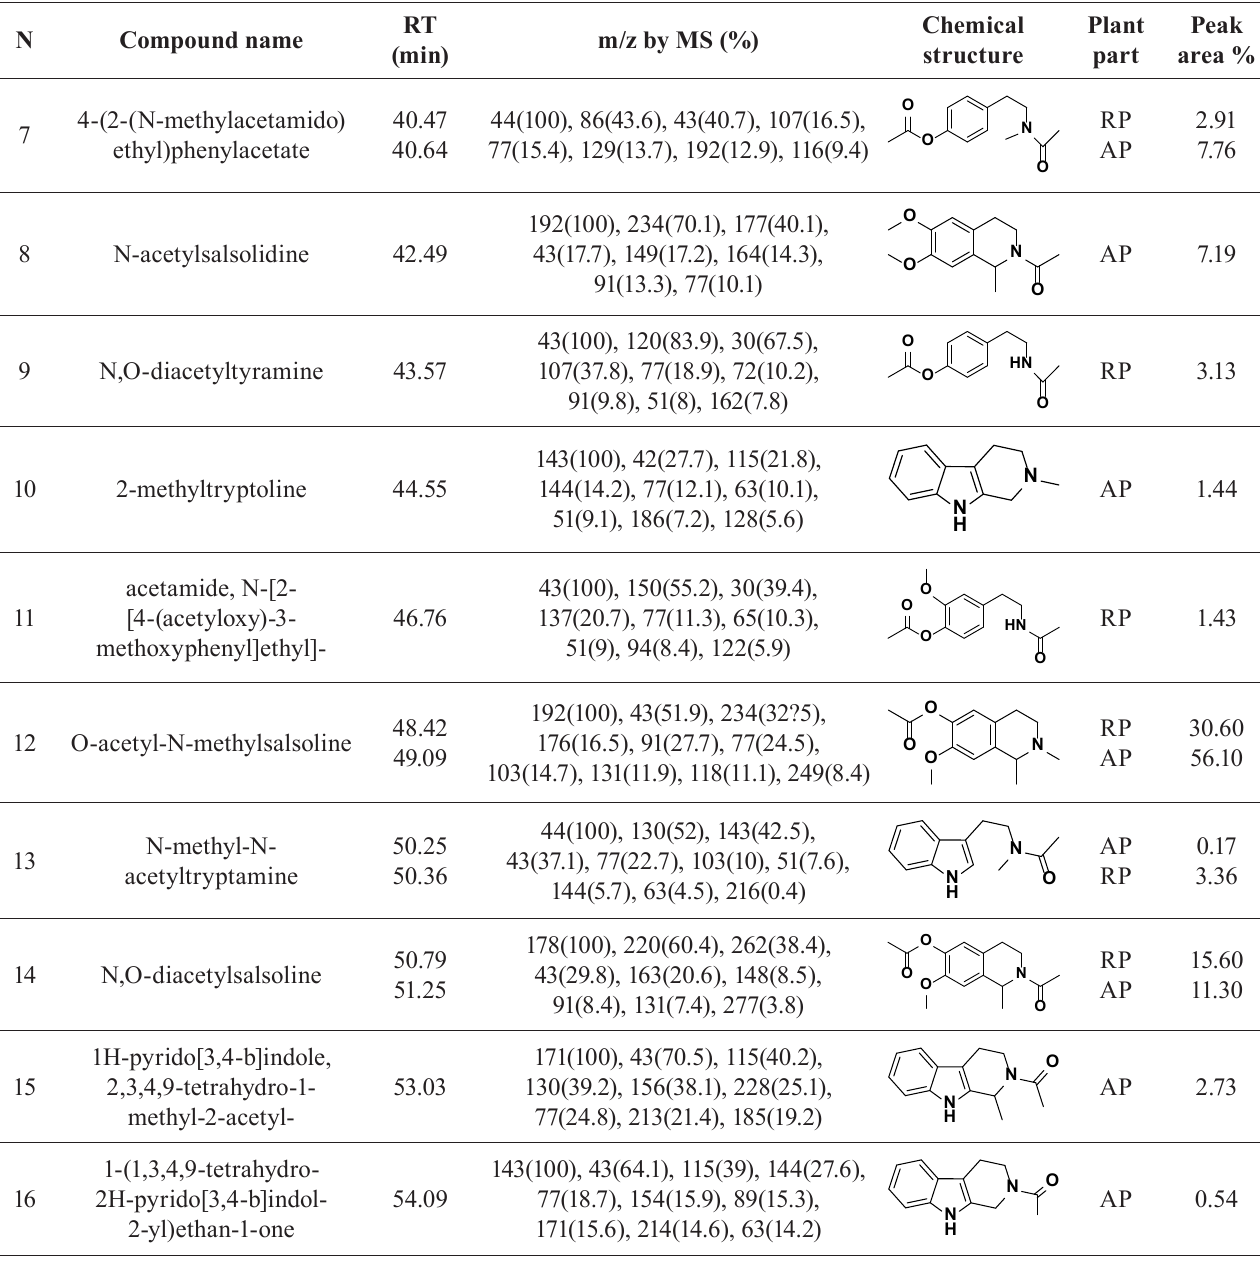
N : Number of the peak in the figure 3; RT : Retention Time; AP : Aerial Part, RP : Root Part; m/z by MS (%) : Characteristic peaks obtained by Mass Spectrometry analysis (relative abundance of peaks in %).